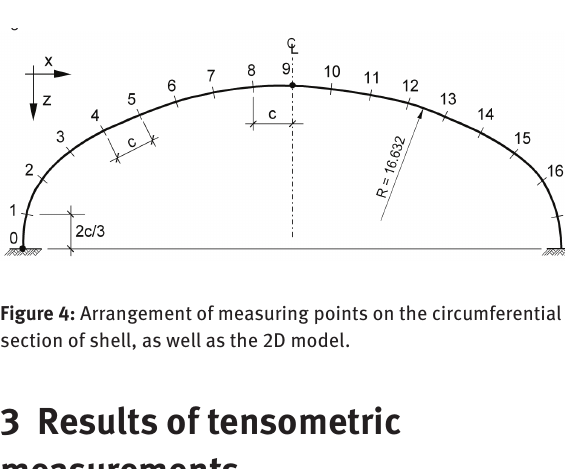
Figure 3: Cross-section of corrugated plate’s circumferential section and distribution of unit strains.